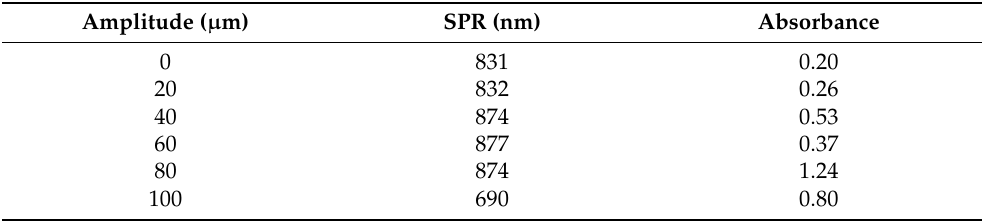
Table 7. The influence of amplitude to surface plasmon resonance and intensity absorbance.